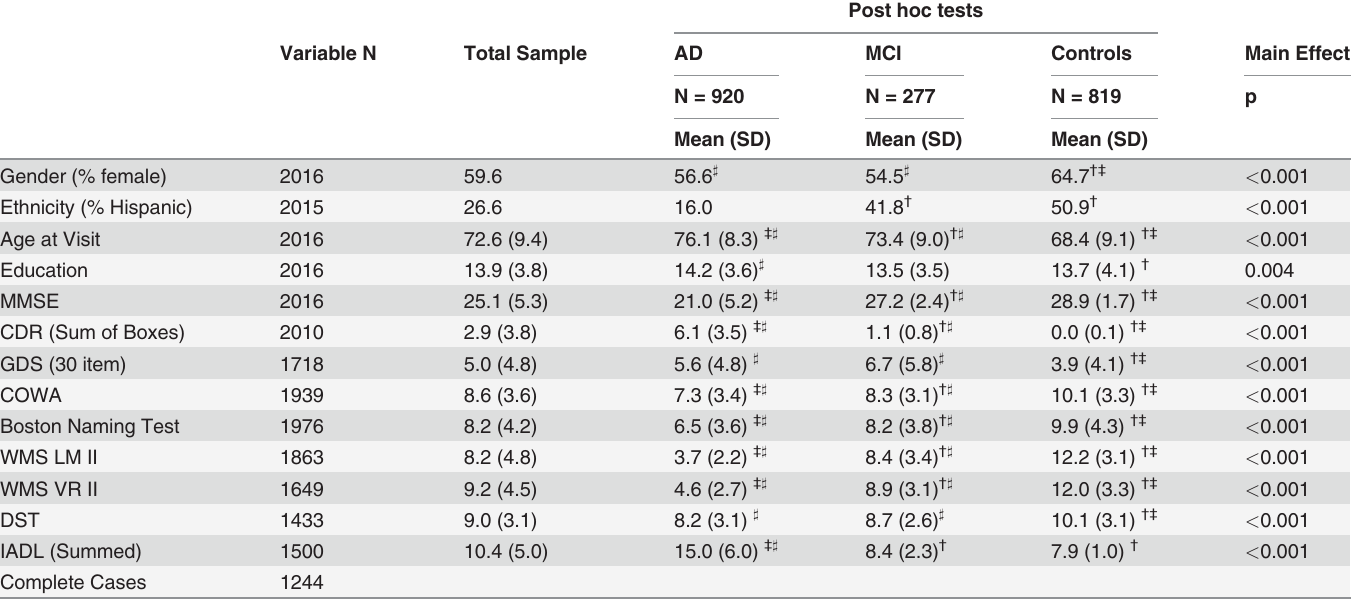
Table 1. Descriptive Statistics